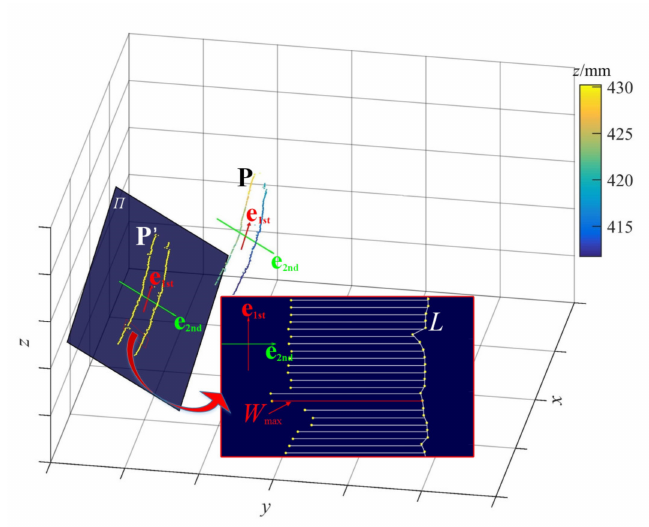
Figure 7. Schematic diagram of rip’s width measurement; the color bar corresponds to the z coordi- nate values; plane Π is the projection plane; W max is the maximum width of the